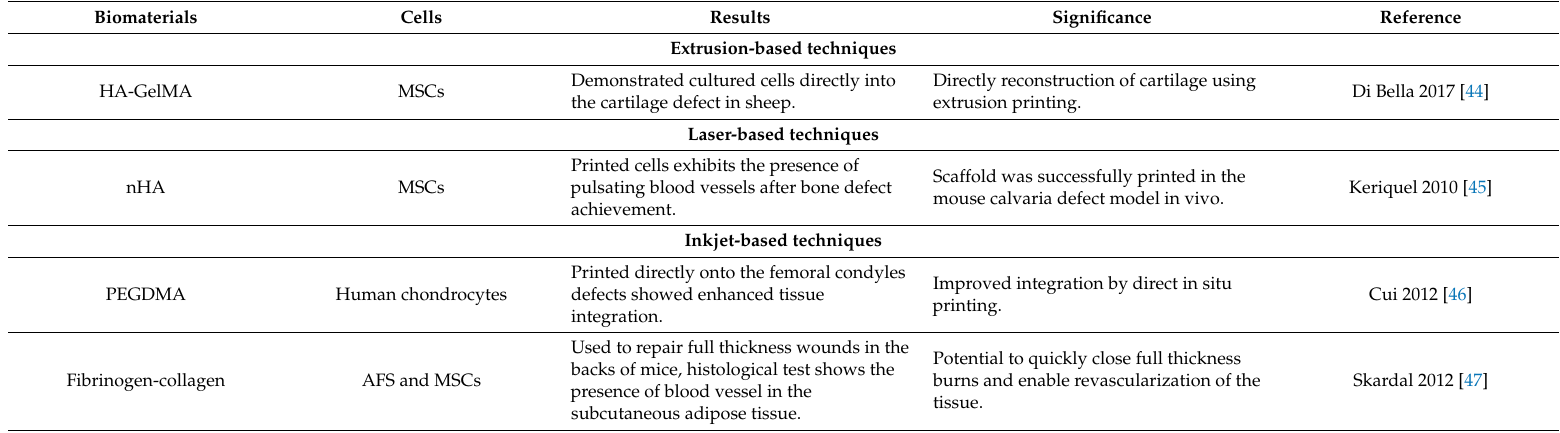
Table 3. Recent in situ studies. Abbreviations: IPFP—Human infrapatellar fat pad-derived adipose stem cells, GelMA—gelatin methacryloyl, HAMa—hyaluronic acid–methacrylate hydrogel, PEGDMA—Poly(ethylene glycol) dimethacrylate, AFS—Amniotic fluid-derived stem cells, MSCs—bone marrow-derived mesenchymal stem